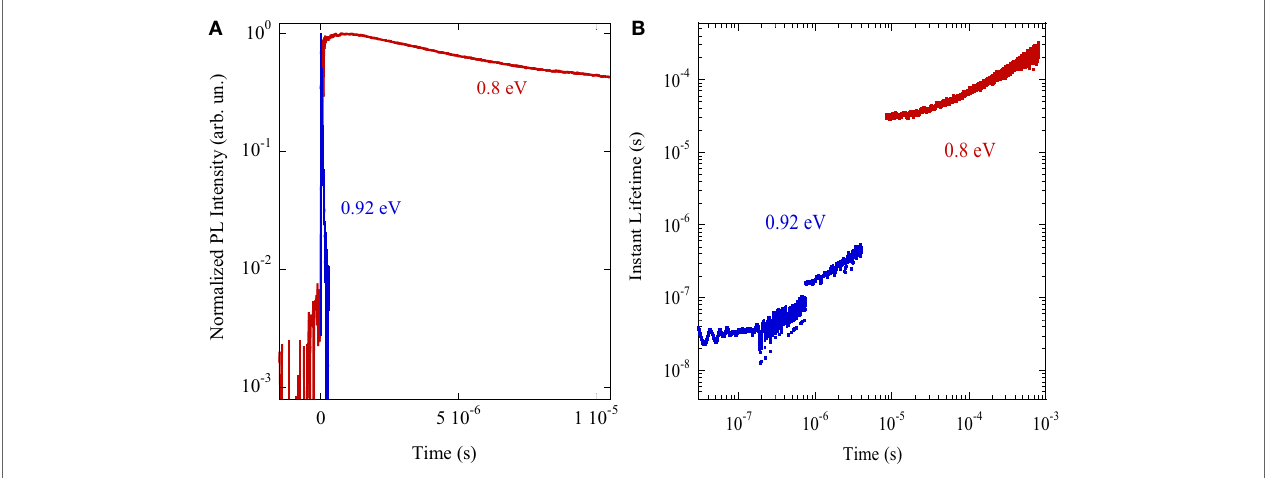
FiGURe 16 | (A) Low-temperature (17 K) time-resolved PL decays under pulsed excitation energy density of 50 mJ/cm 2 recorded at photon energies associated with SiGe NL PL (~ 0.92 eV) and SiGe cluster PL (~ 0.8 eV). (B) Carrier recombination rate as a function of time calculated using the PL decay data. The fast and slow PL decays are from the NL and clusters, respectively (Mala et al.,